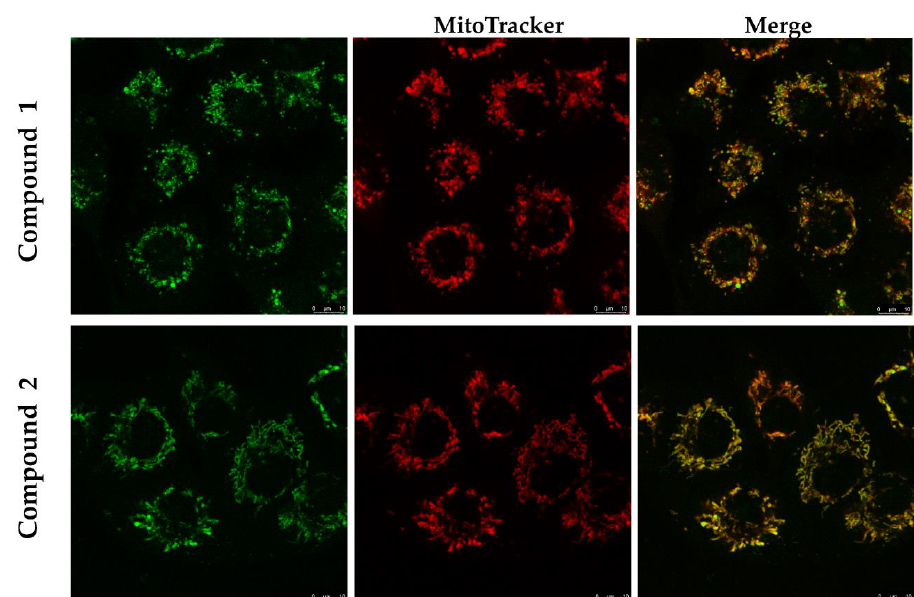
Figure 5. Intracellular distribution of Compounds 1 and 2 compared to MitoTracker. Confocal microscopy of live A549 cells taken on Leica SP8 X confocal microscope, stained with 10 μM of compounds 1 and 2 ( λ exc = 505 nm, λ em = 550 nm); RIGHT : overlay with the MitoTracker Deep Red ( λ exc = 644 nm, λ em = 665 nm).